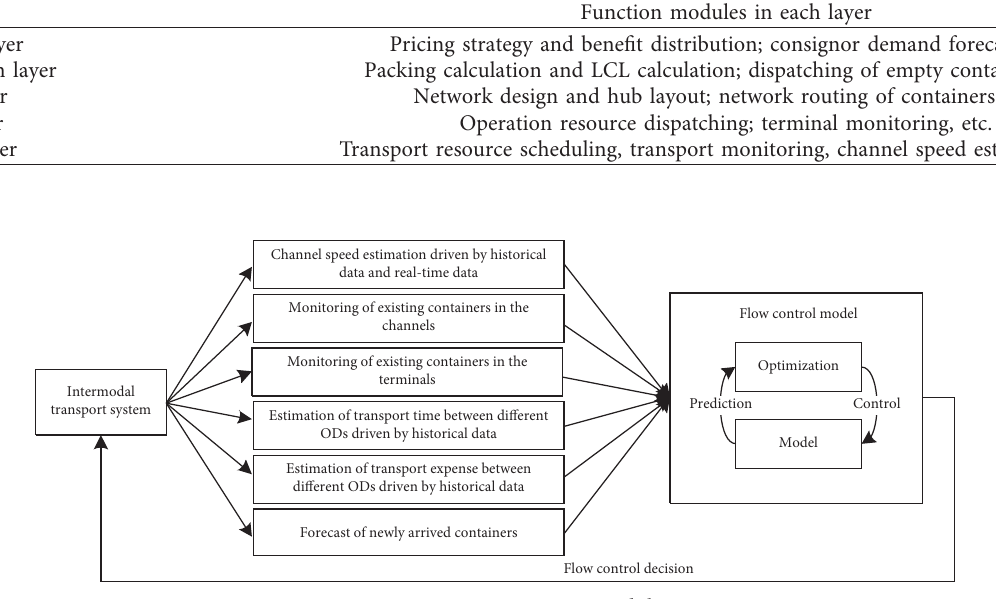
Figure 2: Container routing